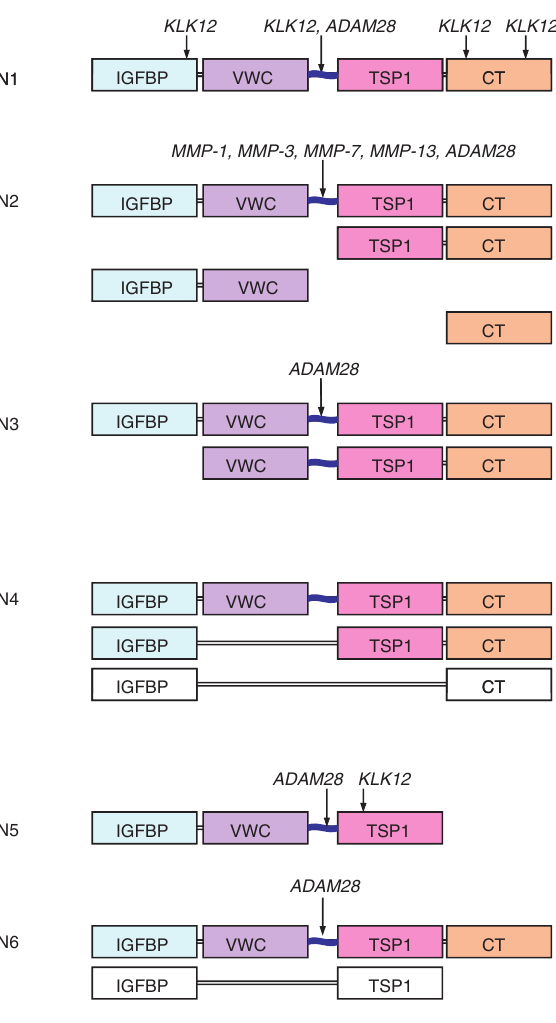
Figure 1 Structure of CCN family